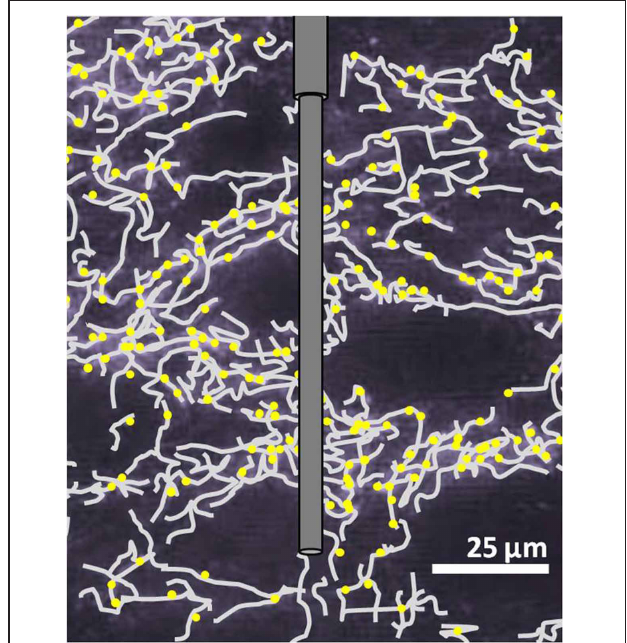
FIGURE 2 | Illustration of a carbon-fiber microelectrode in SNr. Scaling of the microelectrode to in situ serotonergic fibers (gray) and uptake sites (yellow) is a representation based on Moukhles et al.